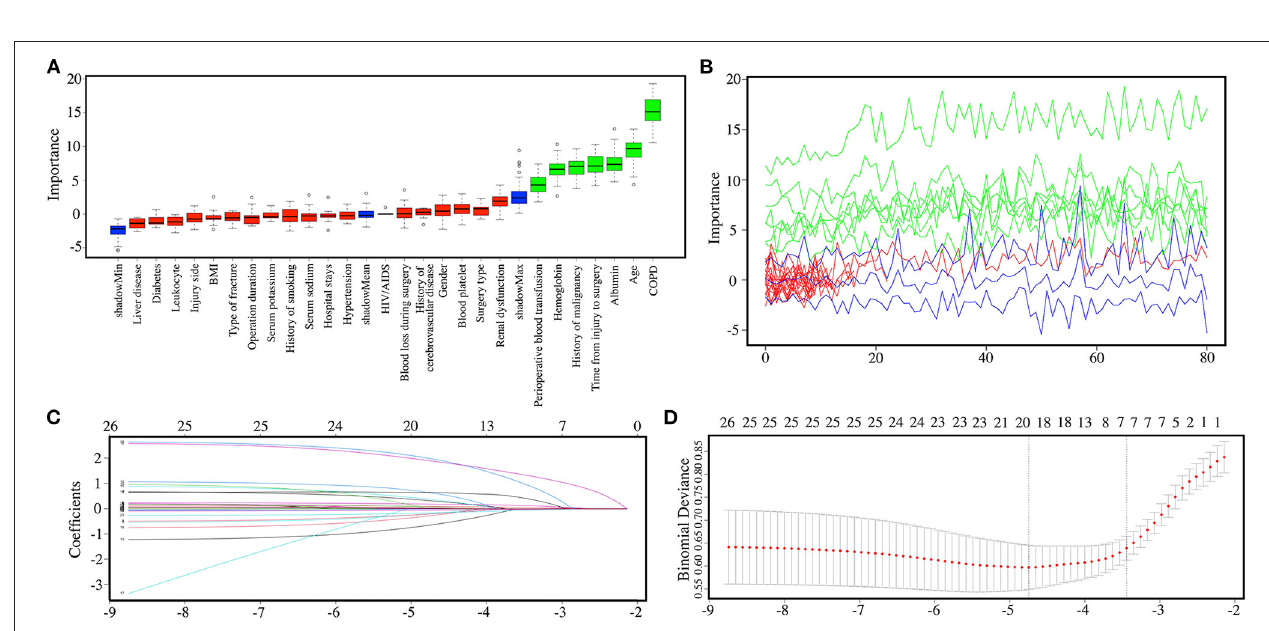
FIGURE 5 | (A) The boxplot reveals the importance of each of the individual variables in random forest algorithm. Boxplots in green, yellow, and blue were confirmed as important, tentative, and unimportant variables, respectively. (B) Decisions of rejecting or accepting features by random forest in 100 Boruta function runs. (C) Lasso coefficient profiles of all features. (D) The tuning parameter λ (lambda) selection in the Lasso regression model used 10-fold cross-validation by minimum criteria.